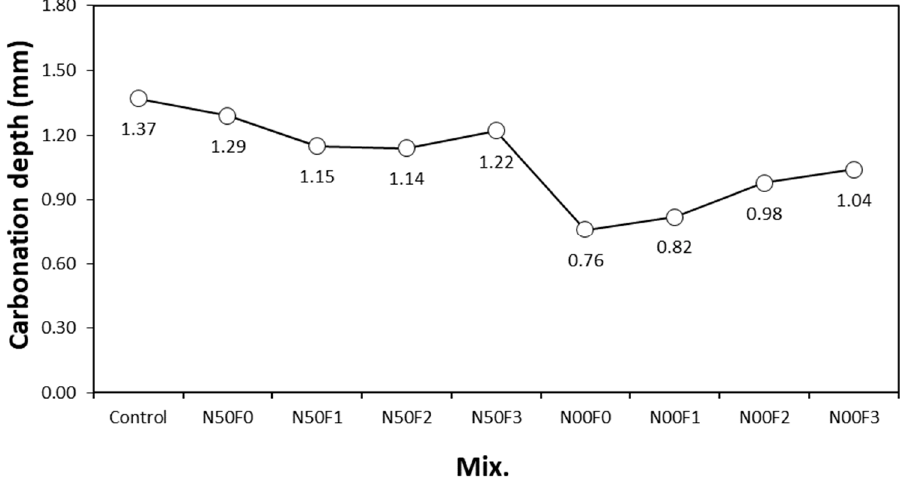
Figure 10. Carbonation depth of different mixture samples.